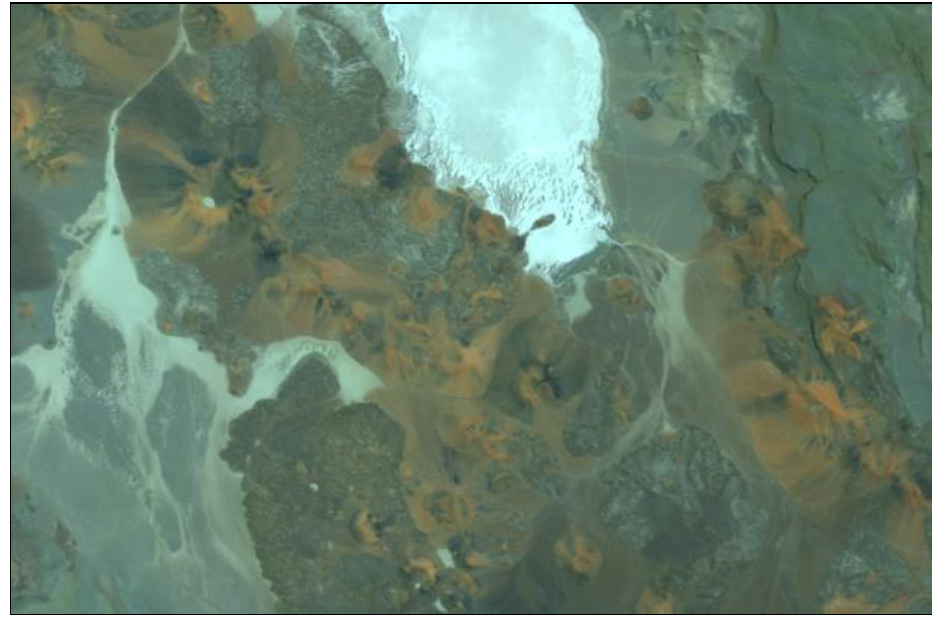
Figure 3. Lunar Lake Scene 03, with band 125 assigned to the red RGB component, band 70 to the green and band 30 to the blue.